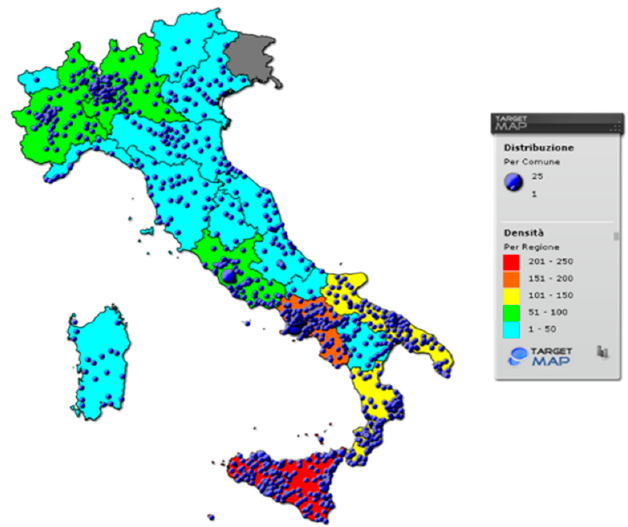
Figure 2. Assemblies of God in Italy.